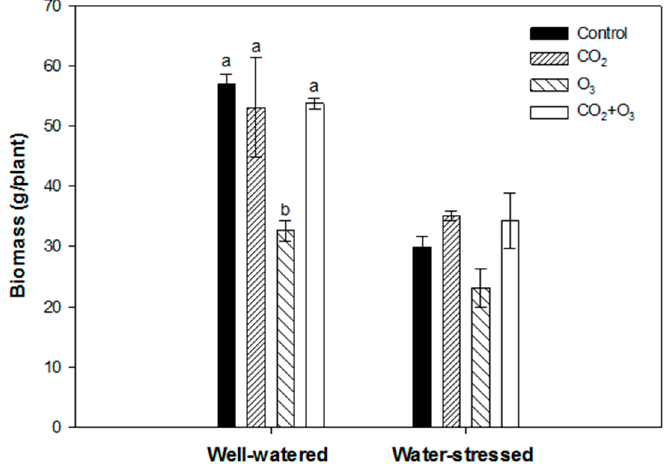
Figure 9. Biomass of wheat exposed to CO 2 , O 3 and CO 2 + O 3 under well-watered and water-stressed conditions after four weeks. For the same water treatment, the different letters show statistically significant differences ( p < 0.05 ).